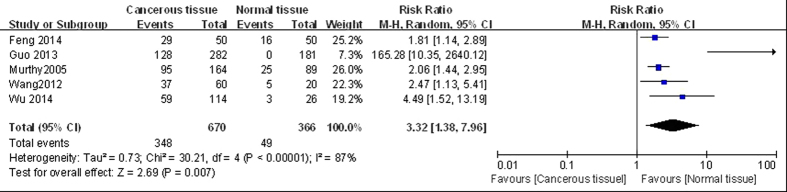
Forest plot of risk ratios of legumain overexpression in cancer tissue vs normal tissue groups.